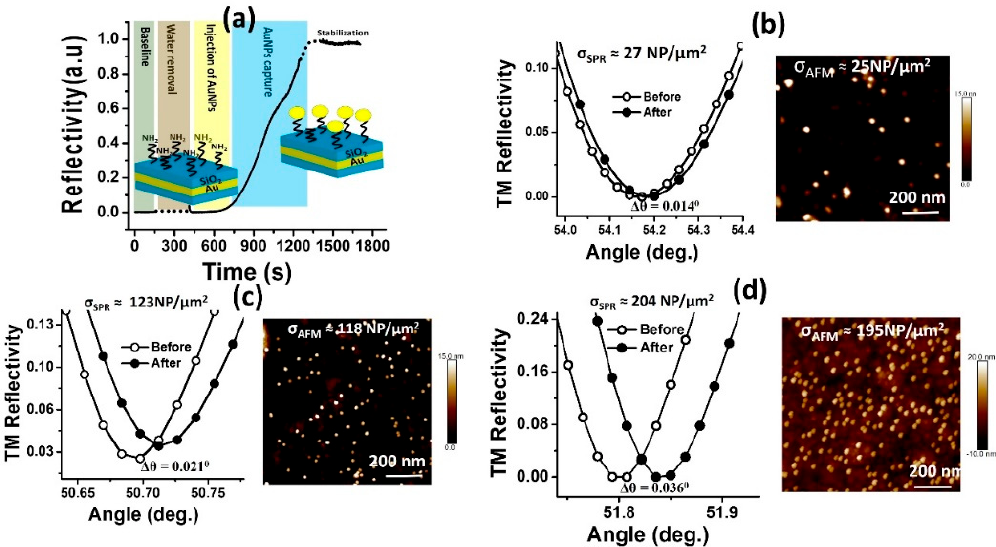
Figure 14. Principle of work of SPR nanoparticle counting with DLWGs. ( a ) SPR sensorgram relative to the sensing of the interaction between the amino group NH 2+ of the external surface of the DLWGs and the negatively charged AuNPs. The TM 1 mode of the DLWG has been used as evanescent optical probe. The excitation wavelength was 783 nm, and the sensorgram was taken at a fixed incidence angle of 50.695 ◦ . ( b ) Comparison between experimental σ SPR and σ AFM in the non-interacting surface density regime: experimental SPR reflectivity curve of the TM1 mode of the DLWGs in water before and after interaction of the AuNPs with the SiO 2 surface (left side), and AFM image of a 1 µ m × 1 µ m region of the SiO 2 surface of the device analyzed by SPR spectroscopy (right size), with a surface density of 25 NP/ µ m 2 . ( c ) σ = 120 NP/ µ m 2 . ( d ) σ = 200 NP/ µ m 2 . The average surface density σ AFM was calculated by analysis of four different regions of each sample.